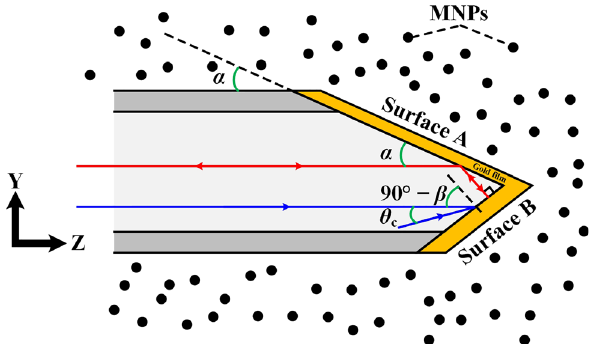
Figure 1: Sensing structure of the wedge-shaped SPR multimode fiber sensing probe.